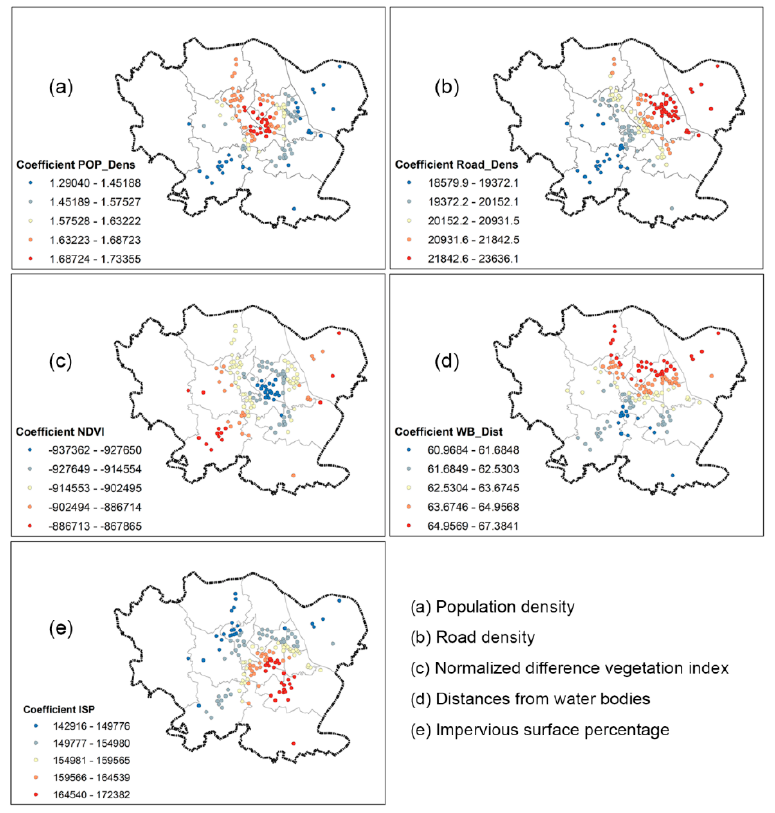
Figure 9. Regression coefficients of the GWR model.